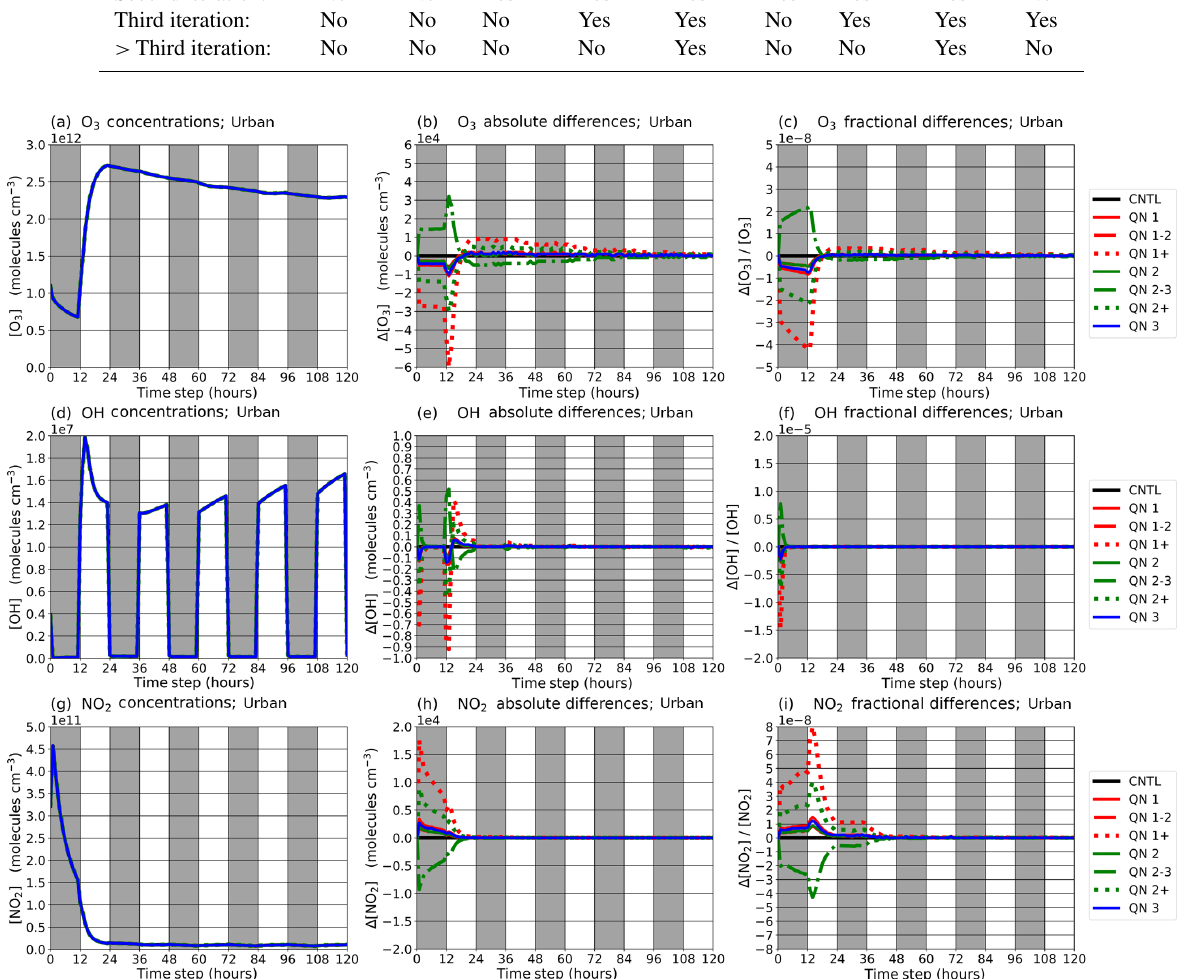
Figure 3. Concentrations of O 3 , OH and NO 2 in molecules cm − 3 from UKCA_BOX simulations of the Urban scenario. The left panels show absolute concentrations from all scenarios, with differences too small to be observed by eye. The centre and rightmost panels show absolute and fractional differences between the CNTL and QN experiments, respectively. The white bands show periods with photolysis on, and grey bands show periods with photolysis